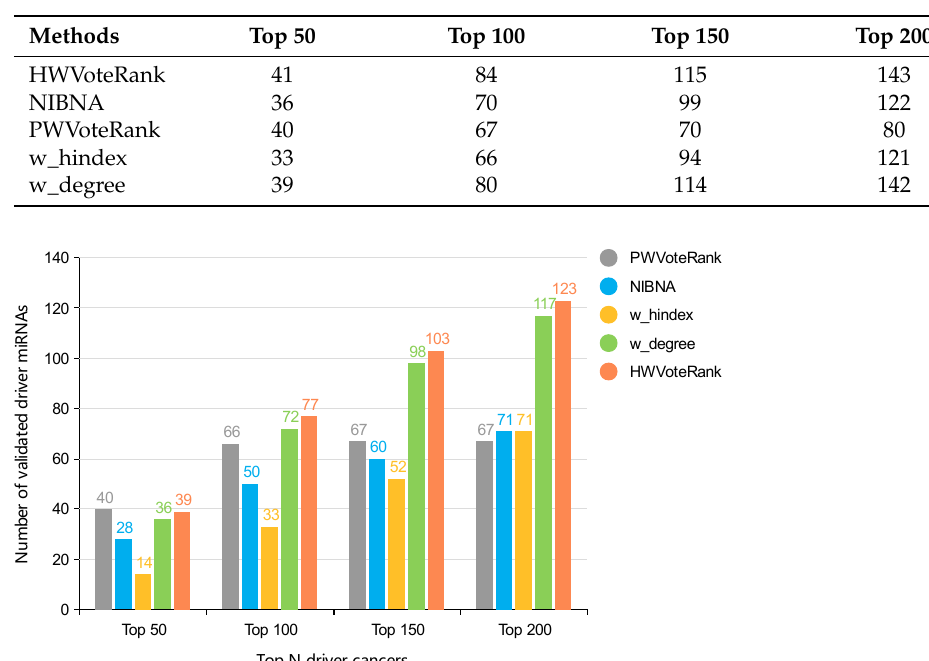
Table 1. The comparison of validated number of cancer drivers among PHVoteRank, NIBNA, HWVoteR- ank, w_hindex, and w_degree in top 200 predicted cancer drivers, excluding genes without mutations.